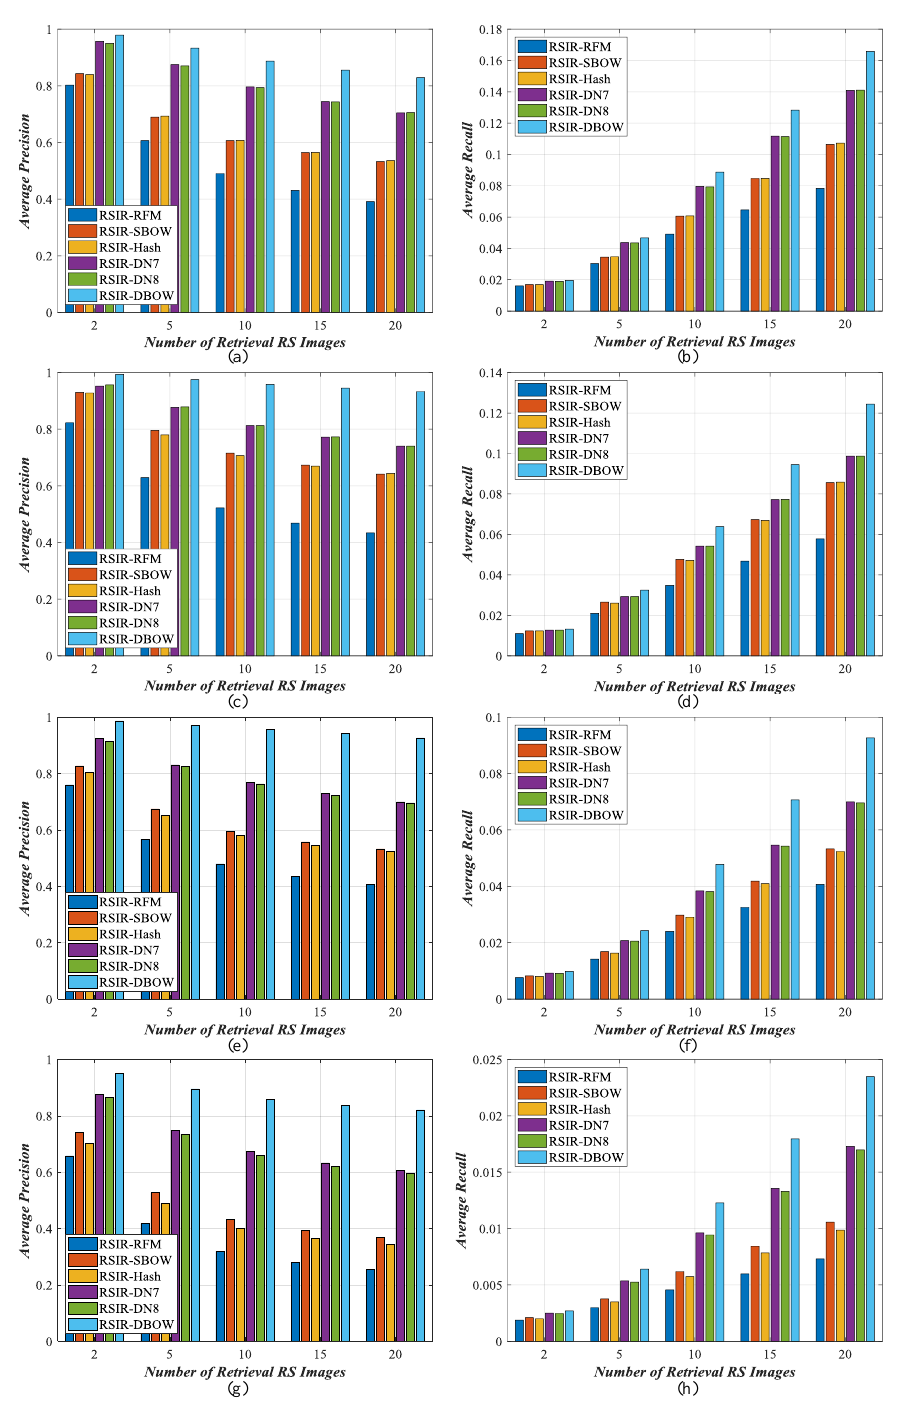
Figure 17. Retrieval performance of different RSIR methods on four RS image sets. ( a ) average retrieval precision on ImgDB1; ( b ) average retrieval recall on ImgDB1; ( c ) average retrieval precision on ImgDB2; ( d ) average retrieval recall on ImgDB2; ( e ) average retrieval precision on ImgDB3; ( f ) average retrieval recall on ImgDB3; ( g ) average retrieval precision on ImgDB4; ( h ) average retrieval recall on